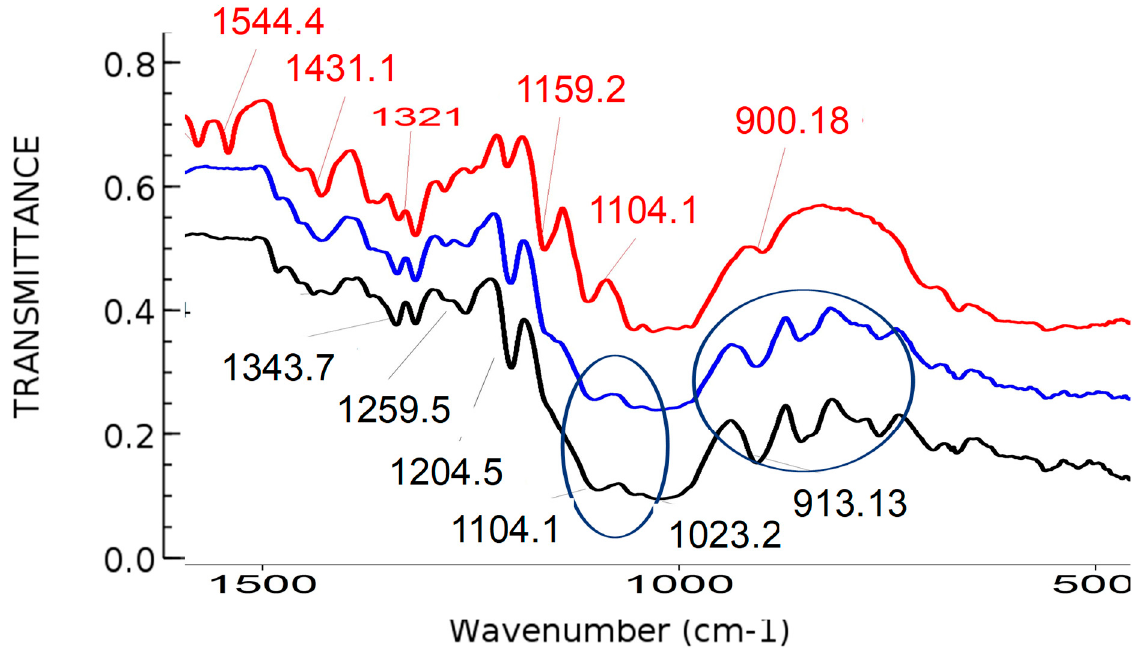
Figure 6. Fourier-transform infrared spectra of the samples before and after the modification: red line—FTIR-Attenuated Total Reflectance (ATR) spectra of cotton woven polymer sample before modification with GLYMO precursor; blue line—FTIR ATR spectra of cellulose sample after modification with organic GLYMO precursor; black line—FTIR ATR spectra of cellulose sample modified with GLYMO precursor and silver. Two blue circles define area of the epoxy groups determined around ~905 and 911 cm − 1 , and the area around 1100 cm − 1 is linked to Si–O groups.